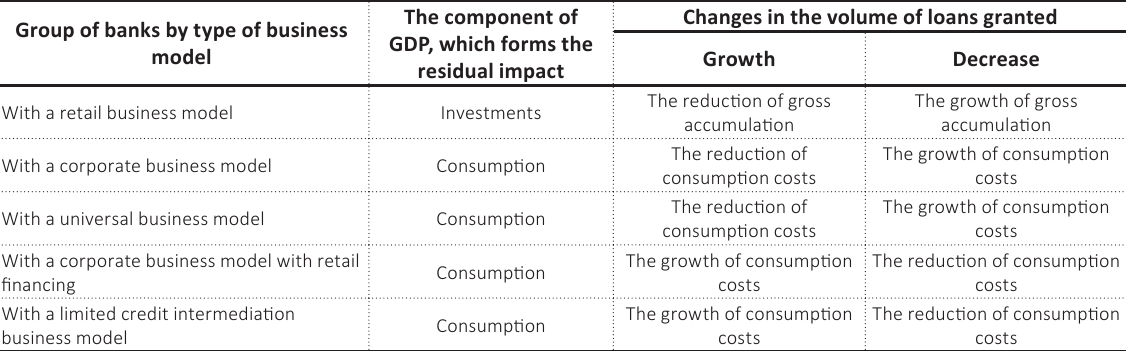
Table 5. Consequences of business architecture